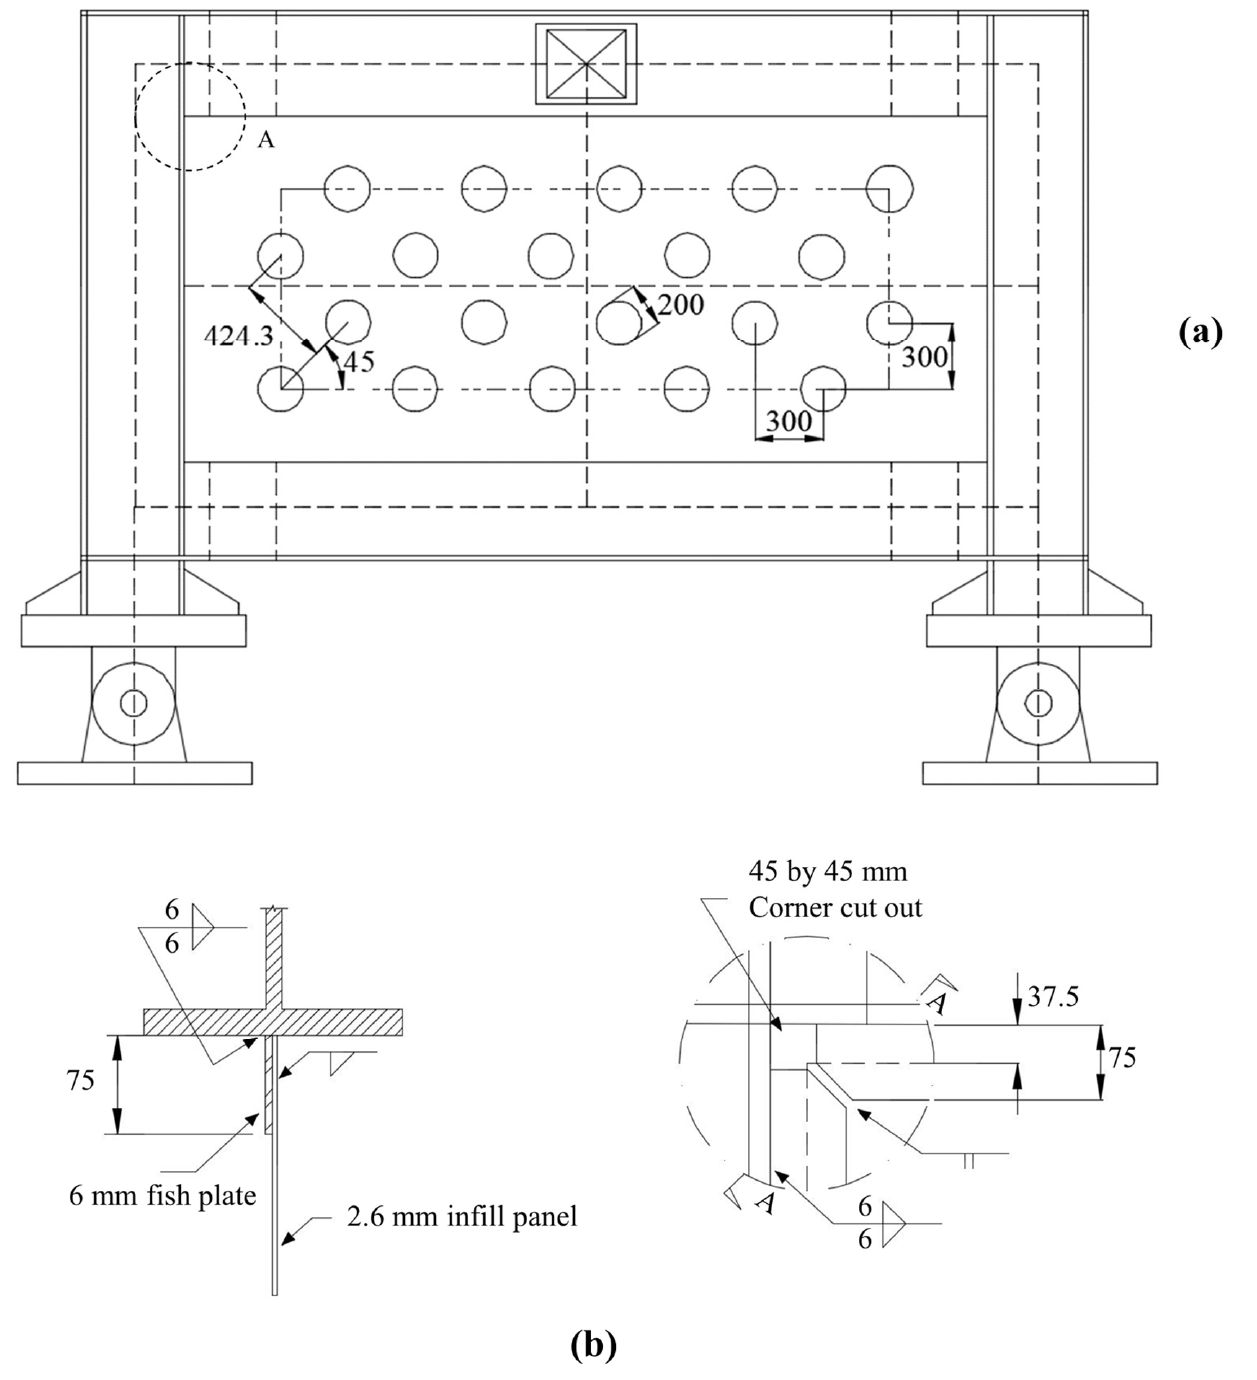
Figure 5. ( a ) Testing model; ( b ) details of the SPSW connection [32].